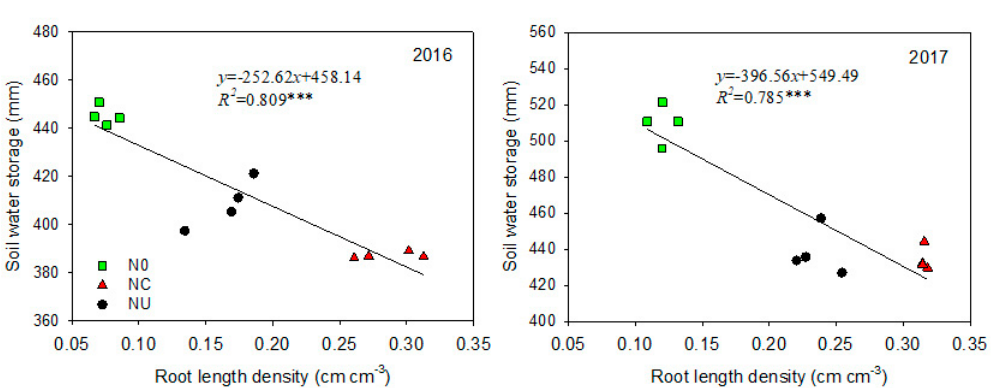
Figure 7. Relationship between root length density and soil water storage with the three treatments in 2016 and 2017 as follows: no N application (N0), combined controlled release urea and normal urea at a ratio of 1:2 (NC), and normal urea alone (NU) at the R5 stage. *** significant at p < 0.001.